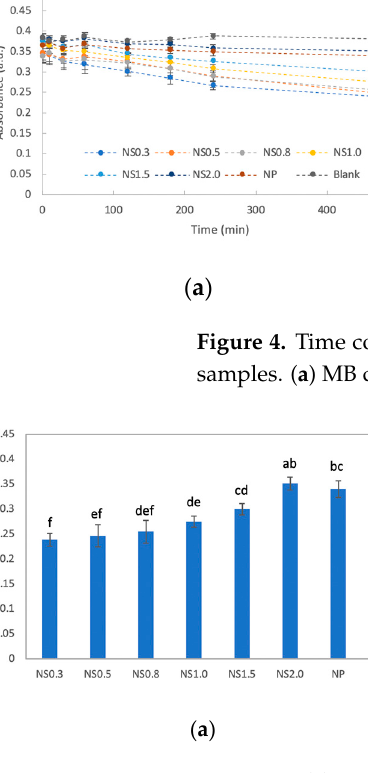
Figure 5. ( a ) Multiple comparisons of the MB absorbance under UV irradiation after 480 min. ( b ) Multiple comparisons of the MB absorbance in the dark after 120 min. The same letter indicates no significant difference at α = 0.05.